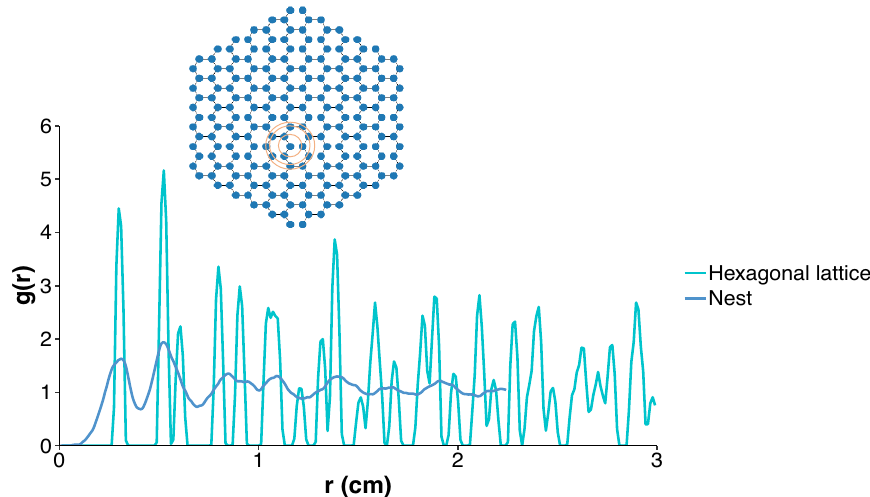
Figure 2. Pair correlation function as a function of r , i.e., the distance between vertices in cm. The two curves depict a representative nest and a regular hexagonal lattice. The regular hexagonal lattice has been constructed with a wall length equal to the average wall length of the representative nest. A schematic on the top shows a regular hexagonal lattice and the vertices in the first, second, and third shells around any one vertex. Each vertex is connected to three other vertices in the first shell.